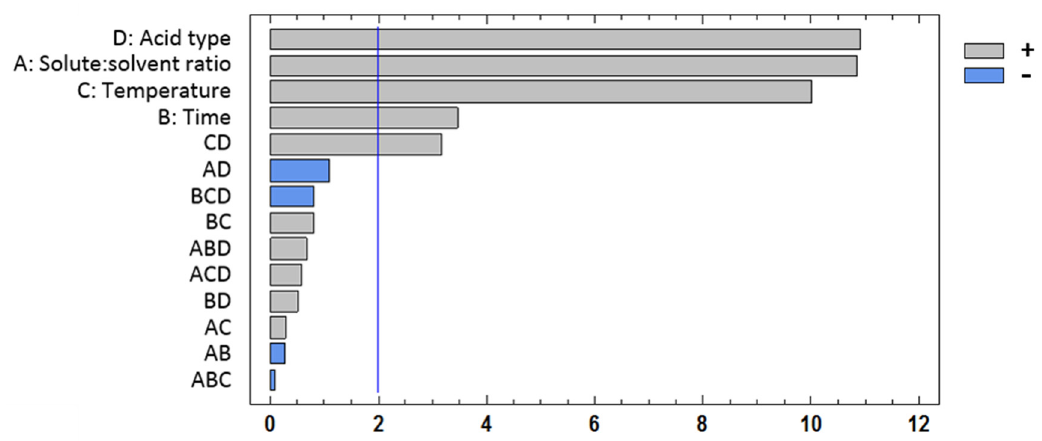
Figure 2. Standardized Pareto analysis of the pectin yield obtained from citrus waste.